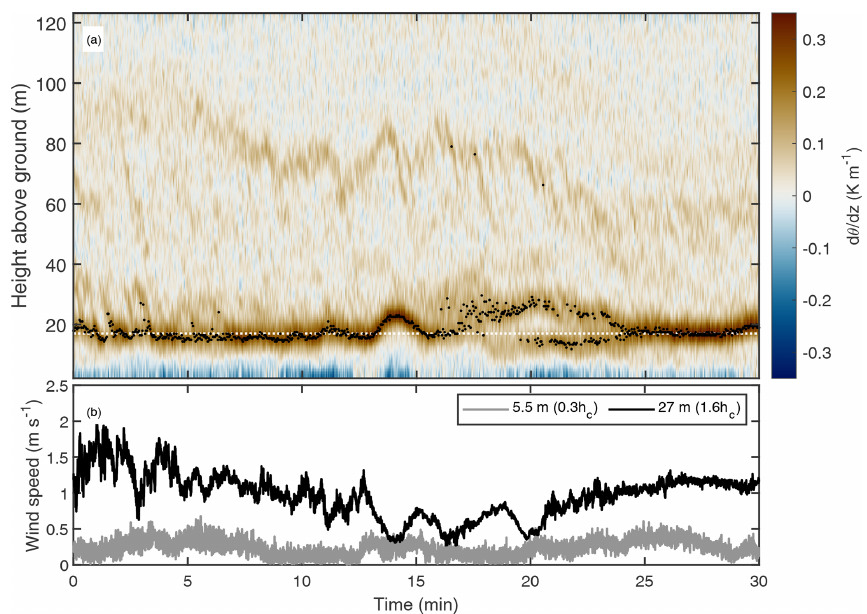
Figure 11. Evolution of potential temperature gradient (d θ/ d z ) (a) for the nighttime period shown in Fig. 10 and concurrent wind speed time series from two heights (b) . The black dots in panel (a) highlight the location of the maximum gradient at each time step. The gradient was calculated using spline fit for each time step and estimating the gradient for each height from the first derivative of the fit. White dotted line shows the canopy